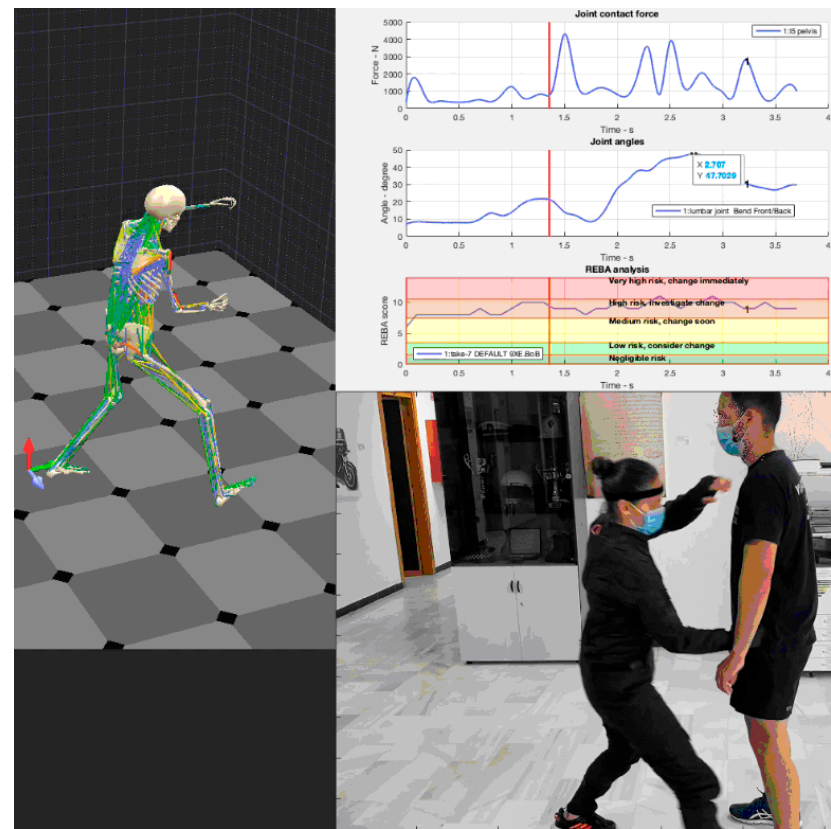
Figure 4. Graphics generated by means of BoB software package.